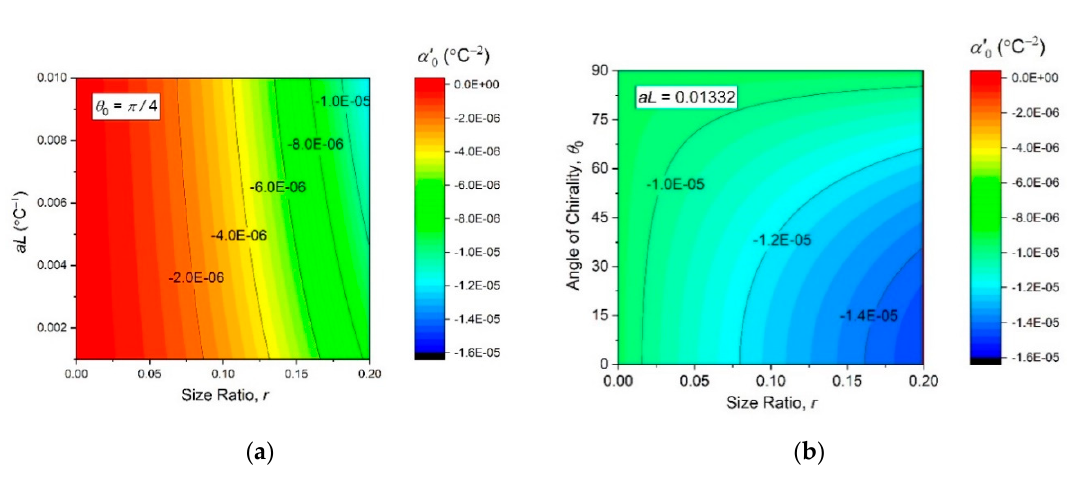
Figure 8. Contour plots of the initial thermal hyperexpansivity (14) as function of the independent design parameters ( 𝜃 (cid:2868) , 𝑟, and 𝑎𝐿 ).